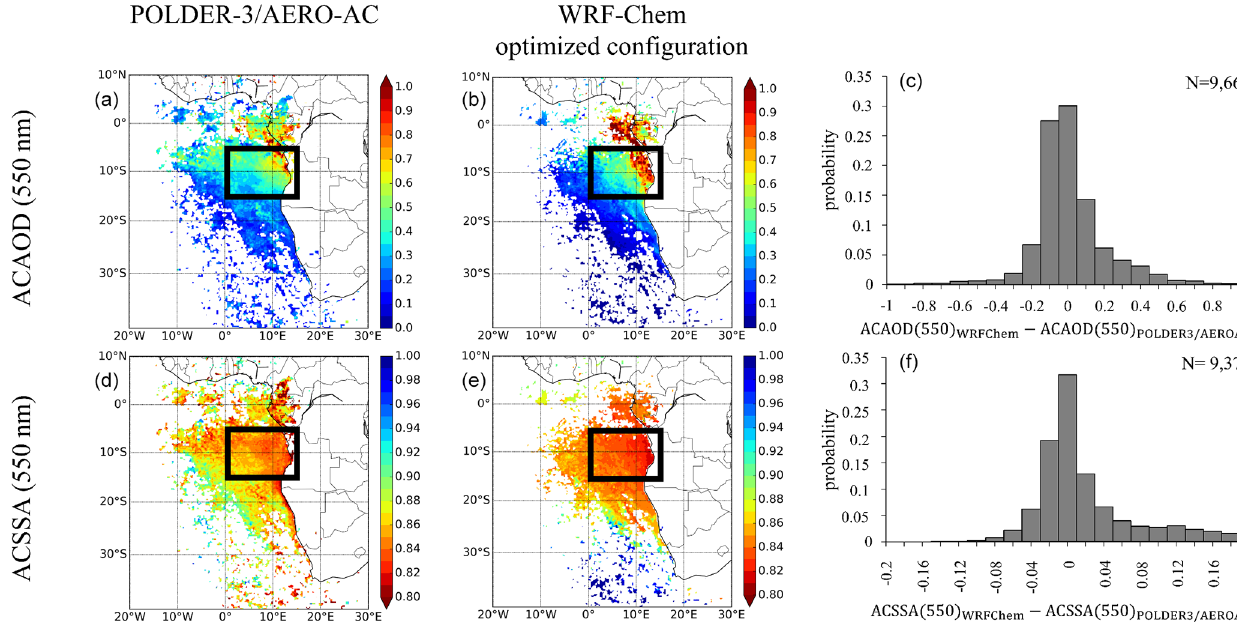
Figure 17. Comparison of monthly averaged ACAOD (a, b) and ACSSA (d, e) at 550nm above clouds retrieved by POLDER-3/AERO-AC (a, d) and simulated with the WRF-Chem optimized configuration (b, e) over the southeast Atlantic region for July 2008, with the associated histograms of differences between the model and the satellite observations over the whole domain (c, f) . The black frames (0–15 ◦ E, 15–5 ◦ S) represent the area of